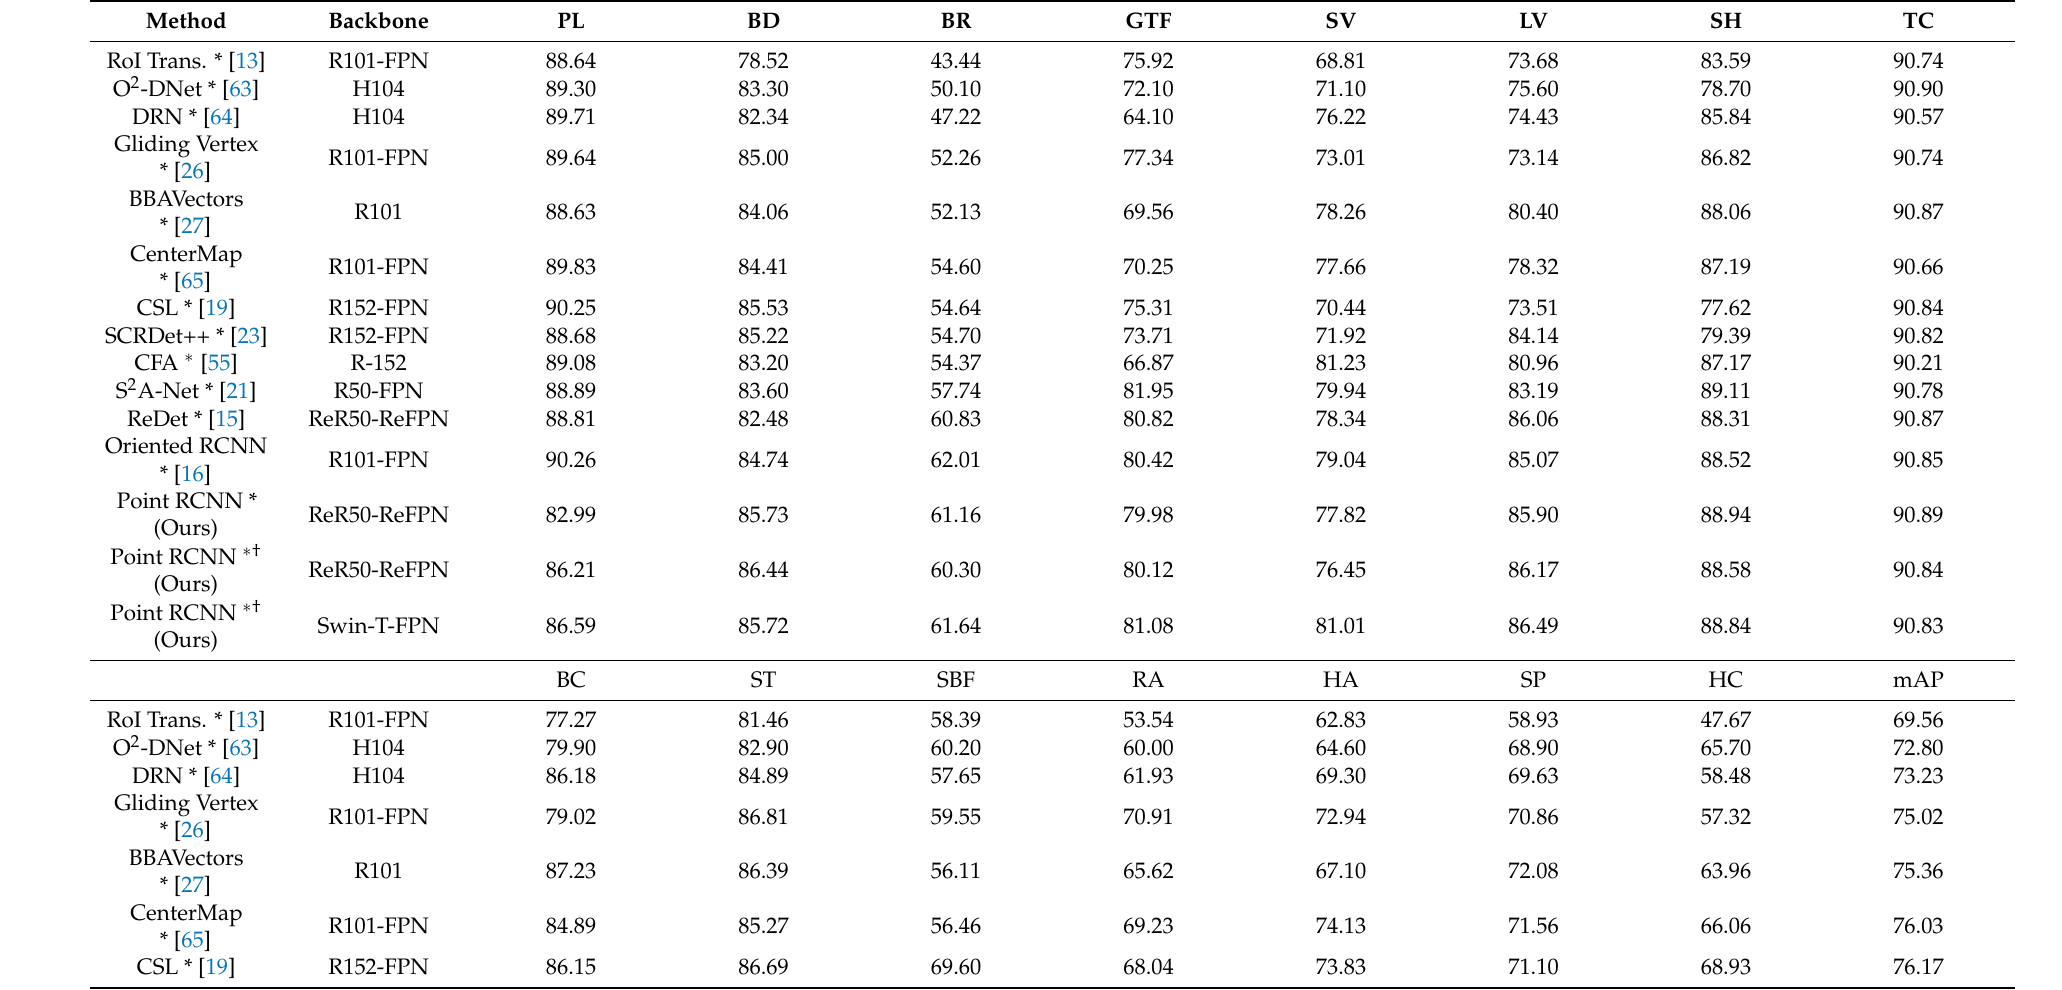
Table 2. Performance comparisons on the DOTA-v1.0 test set (AP (%) for each category and overall mAP (%)). * denotes multi-scale training and testing, * † denotes the results of using our balanced dataset strategy. “R50” denotes ResNet-50, “R101” denotes ResNet-101, “R152” denotes ResNet-152, “H104” denotes